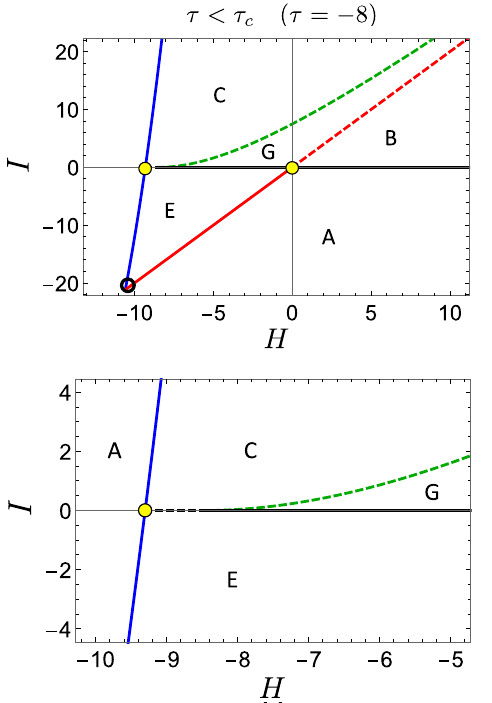
FIG. 19. Bifurcation diagram Σ for the insert strength value τ ¼ − 8 , dividing the ð H; I Þ plane into five distinct regions. (Upper) Default view. The open dot has the same meaning as in Fig. 18. (Lower) Scaled-up view showing clearly the stability of boundaries between regions of type C, G, and E.